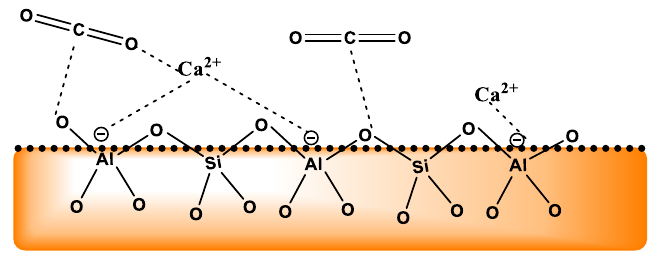
Figure 9. Physisorption CO 2 on